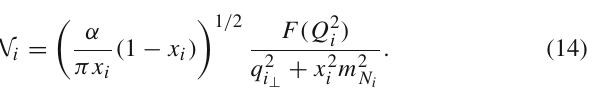
where V μν is the γ γ → X vertex, and the normalization factors are given